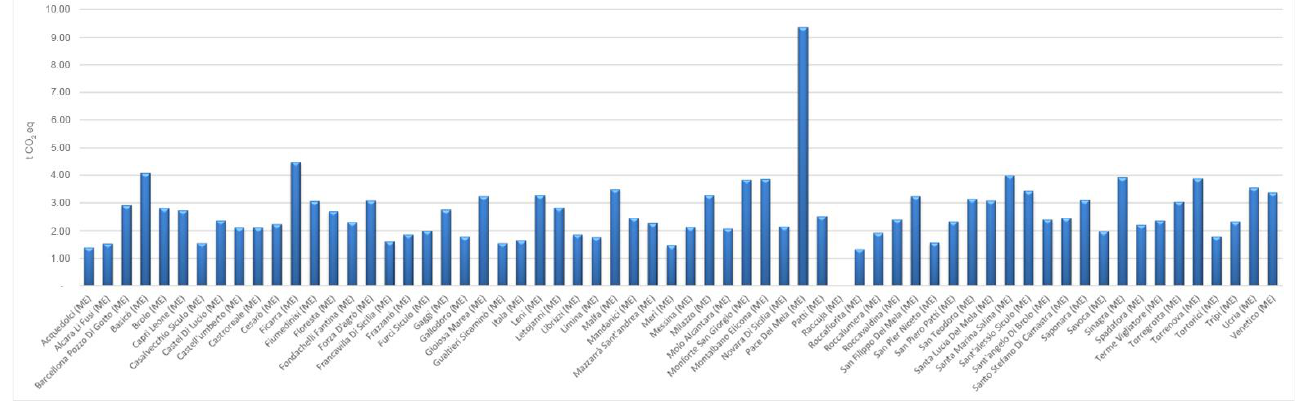
Figure 4. Per capita CO 2 emission (tCO 2 /inh) in Messina’s province.